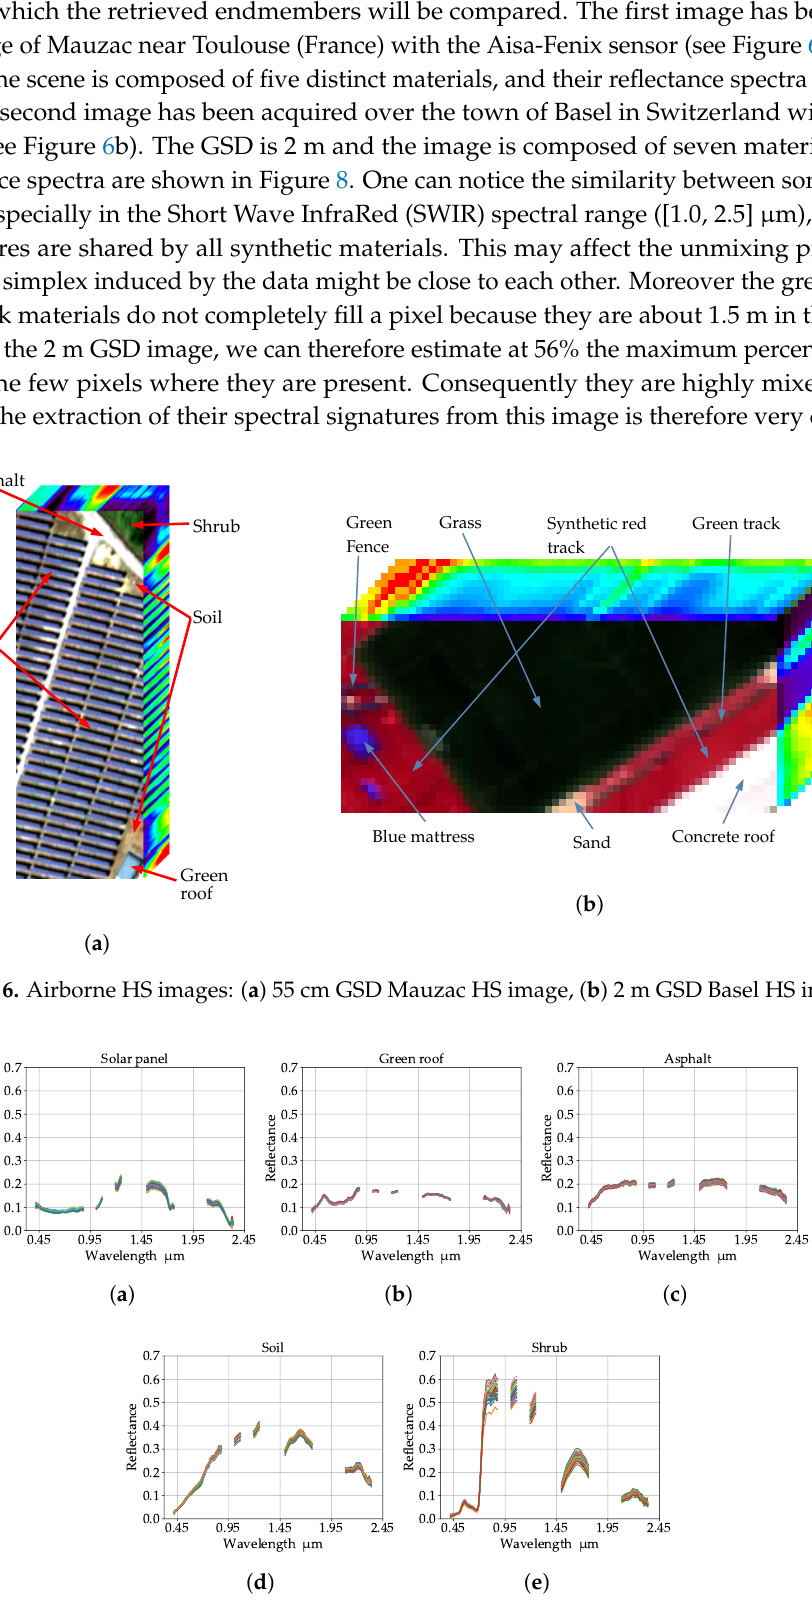
Figure 7. Pure spectra extracted from the Mauzac image for each class of materials. The material classes are: ( a ) solar panel, ( b ) green roof, ( c ) asphalt, ( d ) soil, ( e )